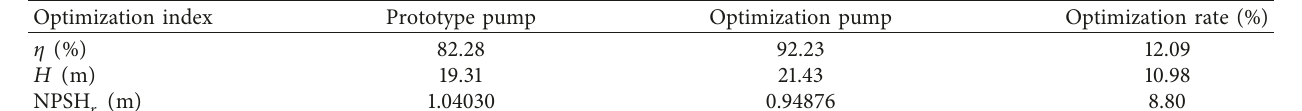
Table 5: Simulation results of external characteristics.